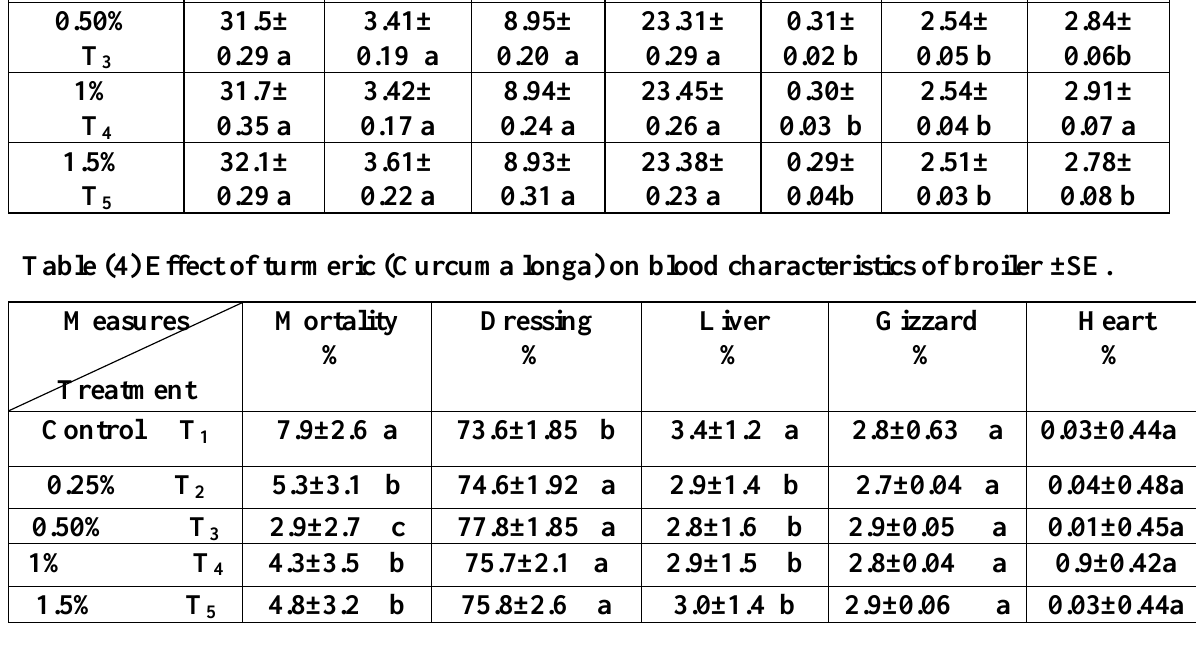
A,b,c Means with different superscript in the same row differ significantly